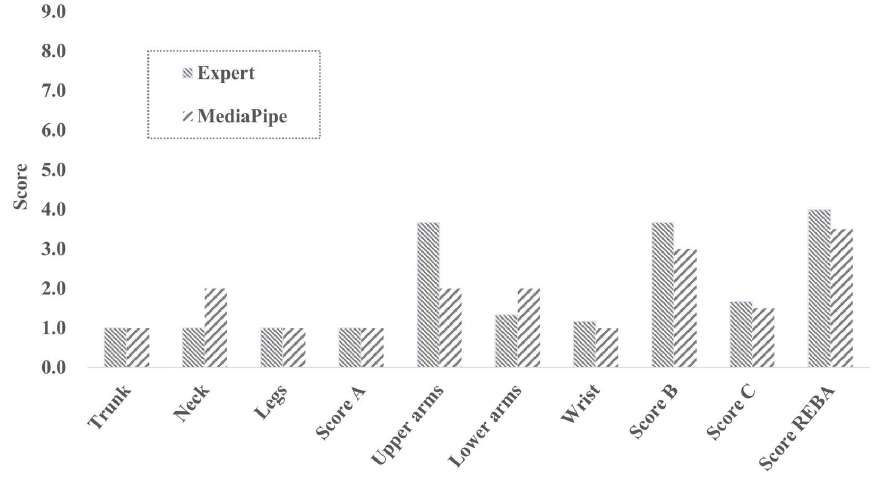
Figure 37. Comparison of drilling machine working posture scores.